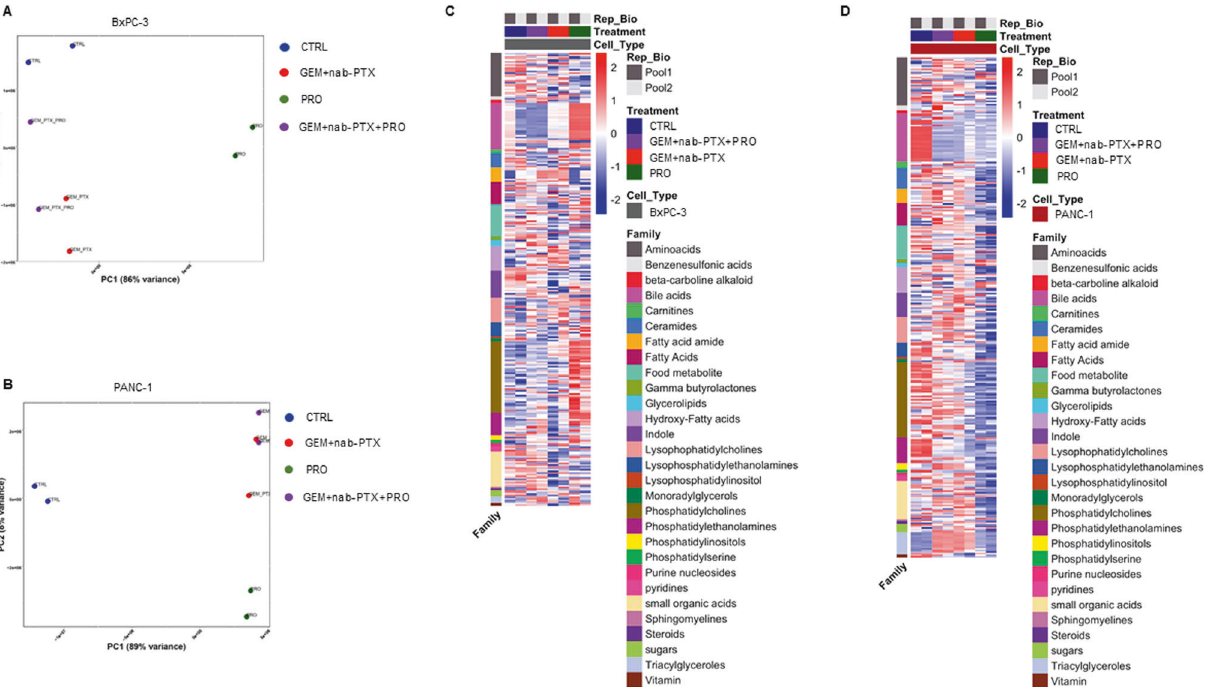
Fig. 7 Effect of chemotherapy and/or probiotic treatment on serum metabolomics in PDAC mice. Score plot from PCA model calculated on the relative concentrations (as measured by mass spectrometry peak intensity) of the serum signi fi cantly different compounds (ANOVA, p < 0.05) in the four treatment groups in BxPC-3 bearing mice ( A ) and in PANC - 1 bearing mice ( B ). Heatmap representation of the serum signi fi cantly different metabolites grouped by classes of compounds (ANOVA, adj p < 0.05) in the four groups in BxPC-3 bearing mice ( C ) and in PANC-1 bearing mice ( D ). Two serum pools per experimental group were